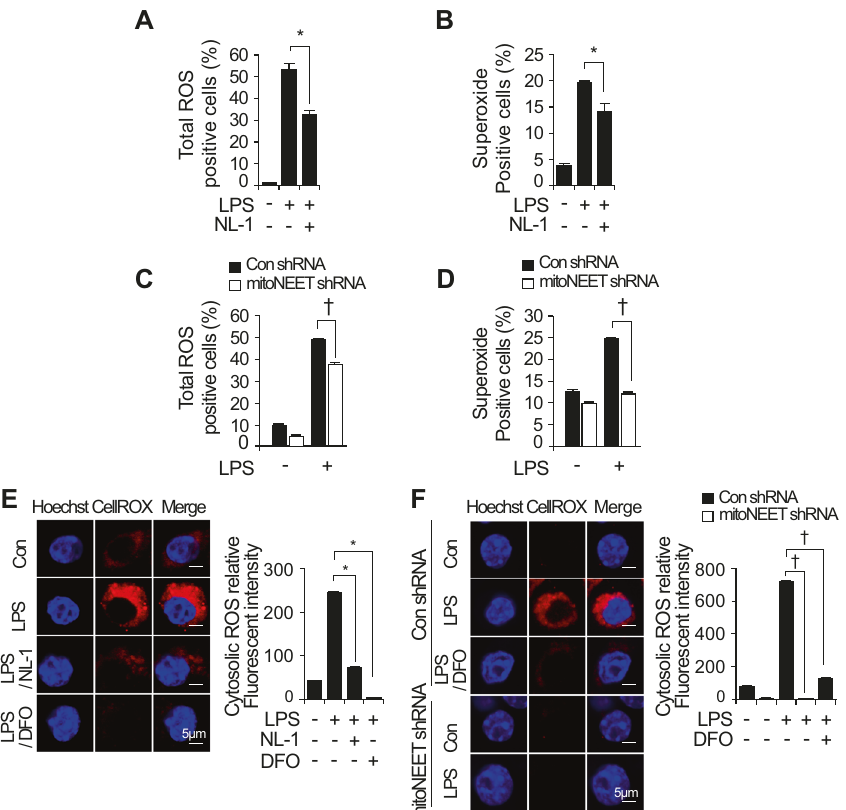
Fig. 5 LPS-induced reactive oxygen species and mitochondrial dysfunction are attenuated by inhibition of mitoNEET. RAW264.7 cells expressing control shRNA or mitoNEET shRNA were treated with vehicle, LPS (1 µg/mL), or LPS plus NL-1 (20 µM) for 24 h. Total reactive oxygen species (ROS) and superoxide anions were assayed by fl ow cytometry using a ROS/Superoxide Detection kit ( A – D ). All data shown are expressed as the mean ± SD from three independent experiments. *P < 0.05 for LPS vs. LPS plus NL-1 treatment; † P < 0.05 for control shRNA- expressing cells vs. mitoNEET shRNA-expressing cells in the presence of LPS. *P < 0.05 indicates a signi fi cant decrease compared with vehicle; † P < 0.05 indicates signi fi cant decrease compared with control siRNA. RAW264.7 cells expressing control shRNA or mitoNEET shRNA were treated with vehicle or LPS (1 µg/mL) for 12 h. Cells were then stained with the fl uorescent probes Hoechst 33258 (nuclei, blue) and CellROX ® Deep Red (total ROS, red). Immuno fl uorescence images of cells stained with Hoechst 33258 (nuclei, blue) and CellROX ® Deep Red (total ROS, red) ( E and F ). Scale bar: 5 µm. Fluorescence intensity was measured using image analysis software (ImageJ). All data are expressed as the mean ± SD from three independent experiments. *P < 0.05 for LPS vs. LPS plus NL-1 or DFO. † P < 0.05 for control shRNA-expressing cells vs. mitoNEET shRNA-expressing cells in the presence of LPS or vs. LPS plus